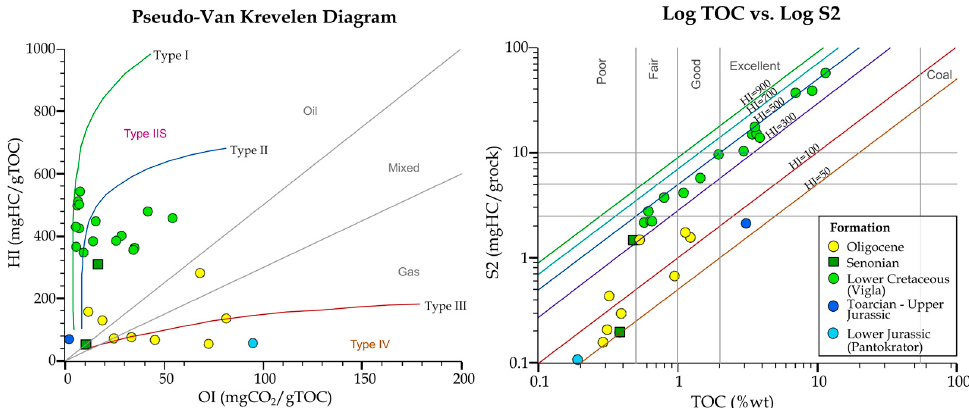
Figure 4. ( Left ): Pseudo van Krevelen diagram showing hydrogen (HI; 100xS2/TOC in mgHC/gTOC) and oxygen indices (OI; 100xS3/TOC in mgCO 2 /gTOC). Kerogen type lines represent typical kerogen maturity paths based on [73]. ( Right ): Plot of the TOC (%wt) versus S2 (mgHC/grock). HI annotated in lines is measured in mgHC/gTOC [72,74]. Legend applies for both plots.